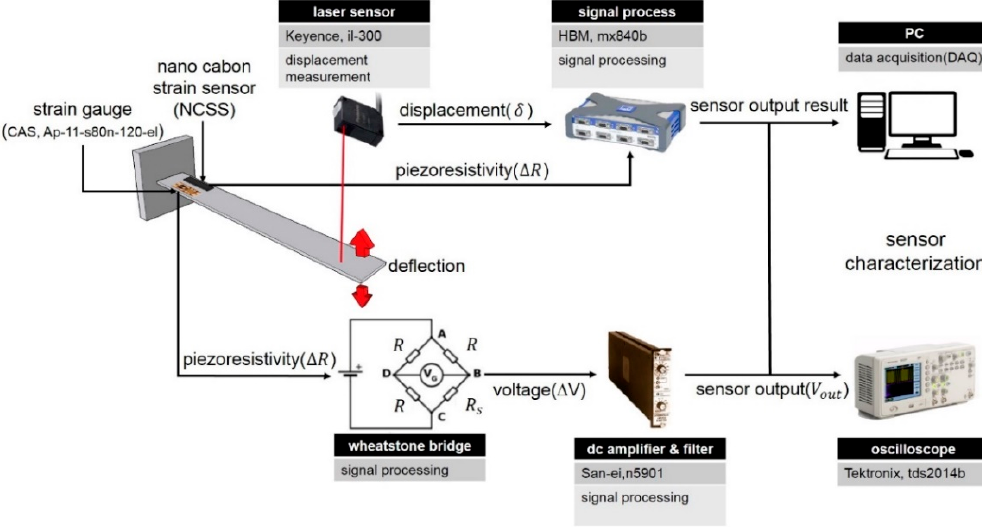
Figure 3. Schematic illustration of the strain measurement.